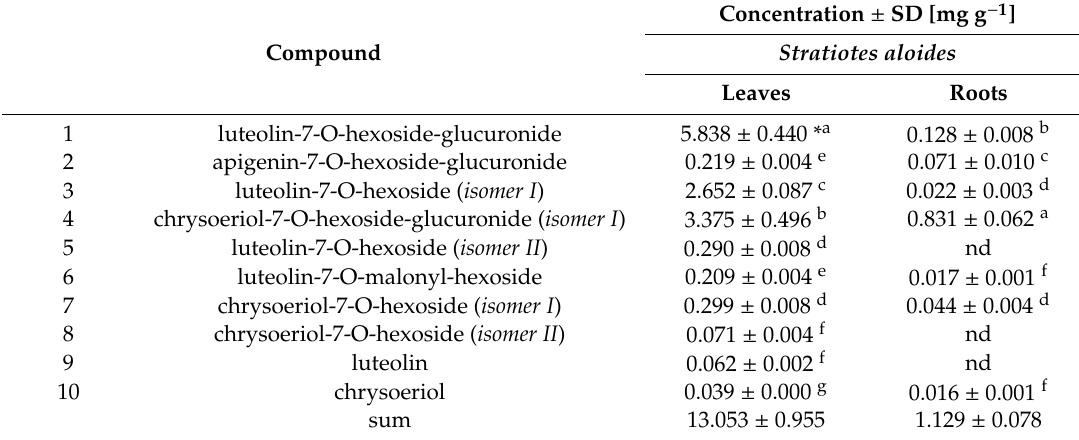
Table 1. Qualitative and quantitative UPLC-MS / MS analysis of phenolics from the leaves and roots of Stratiotes aloides ( n = 9